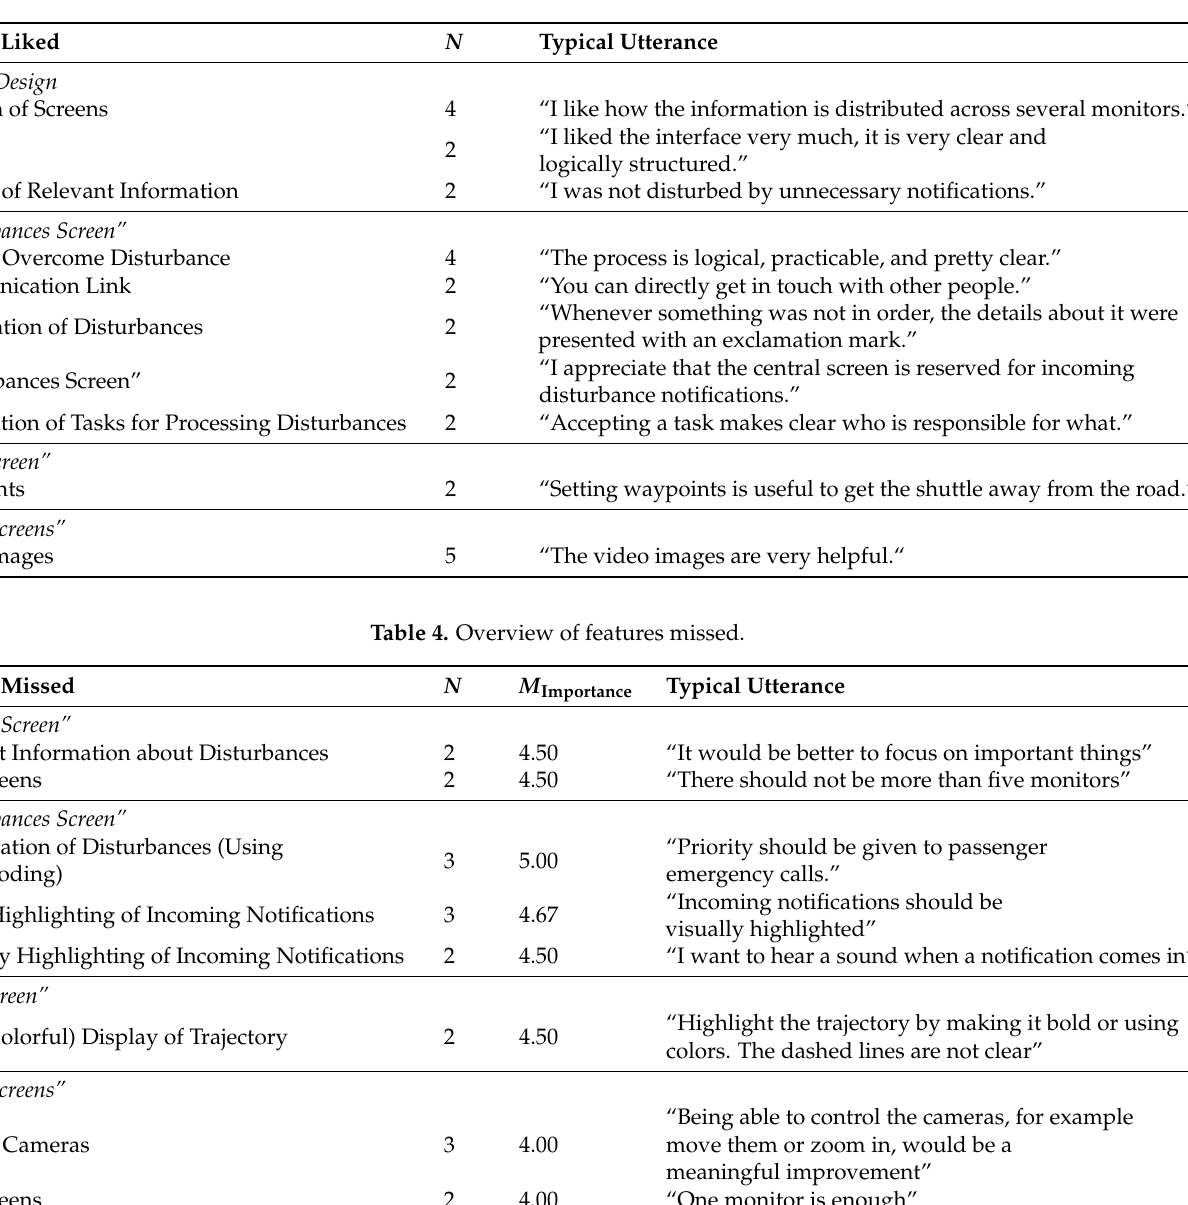
Table 3. Overview of features liked.